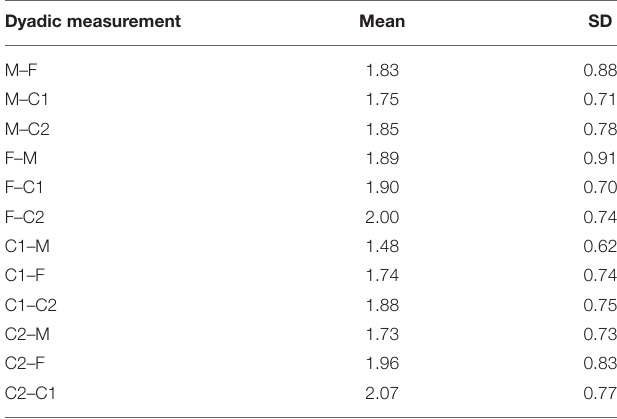
TABLE 2 | Mean and standard deviation (SD) of each dyadic measurement in the normative